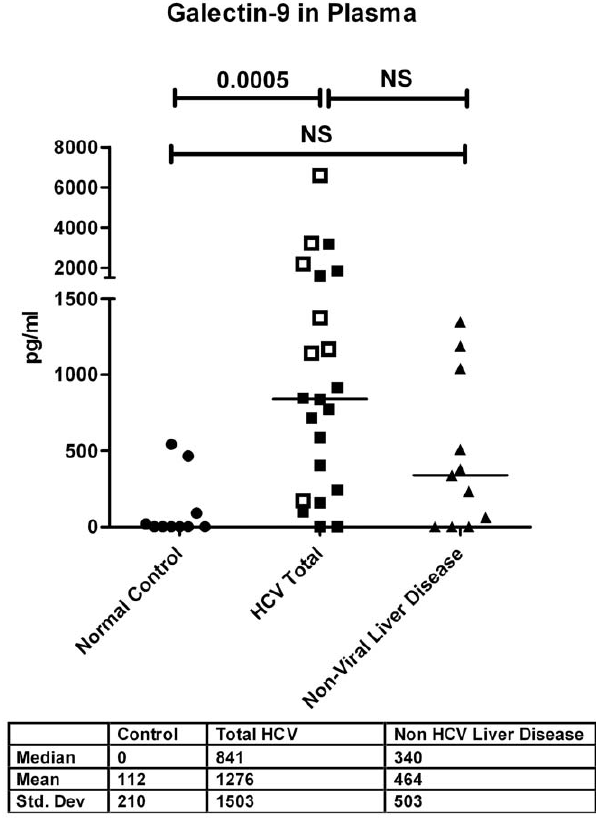
Figure 1. Galectin-9 is elevated in the plasma of patients with chronic HCV and higher levels are seen in hepatocellular carcinoma (HCC). Galectin-9 levels were analyzed in the plasma of 10 normal controls, 22 patients with HCV and 11 patients with non-viral causes of liver disease using a sandwich ELISA [50]. Seven patients with HCV and HCC are denoted by open squares; they had significantly higher galectin-9 levels compared to HCV patients without HCC, p=0.0334. Plasma from 11 patients with non-viral liver disease was analyzed. Three patients had alcoholic liver disease, 3 patients had Primary Biliary Cirrhosis, 3 patients had autoimmune hepatitis and 2 patients had non- alcoholic steatohepatitis. P- values were calculated using the two tailed Mann-Whitney test. NS denotes non-significant, p values .